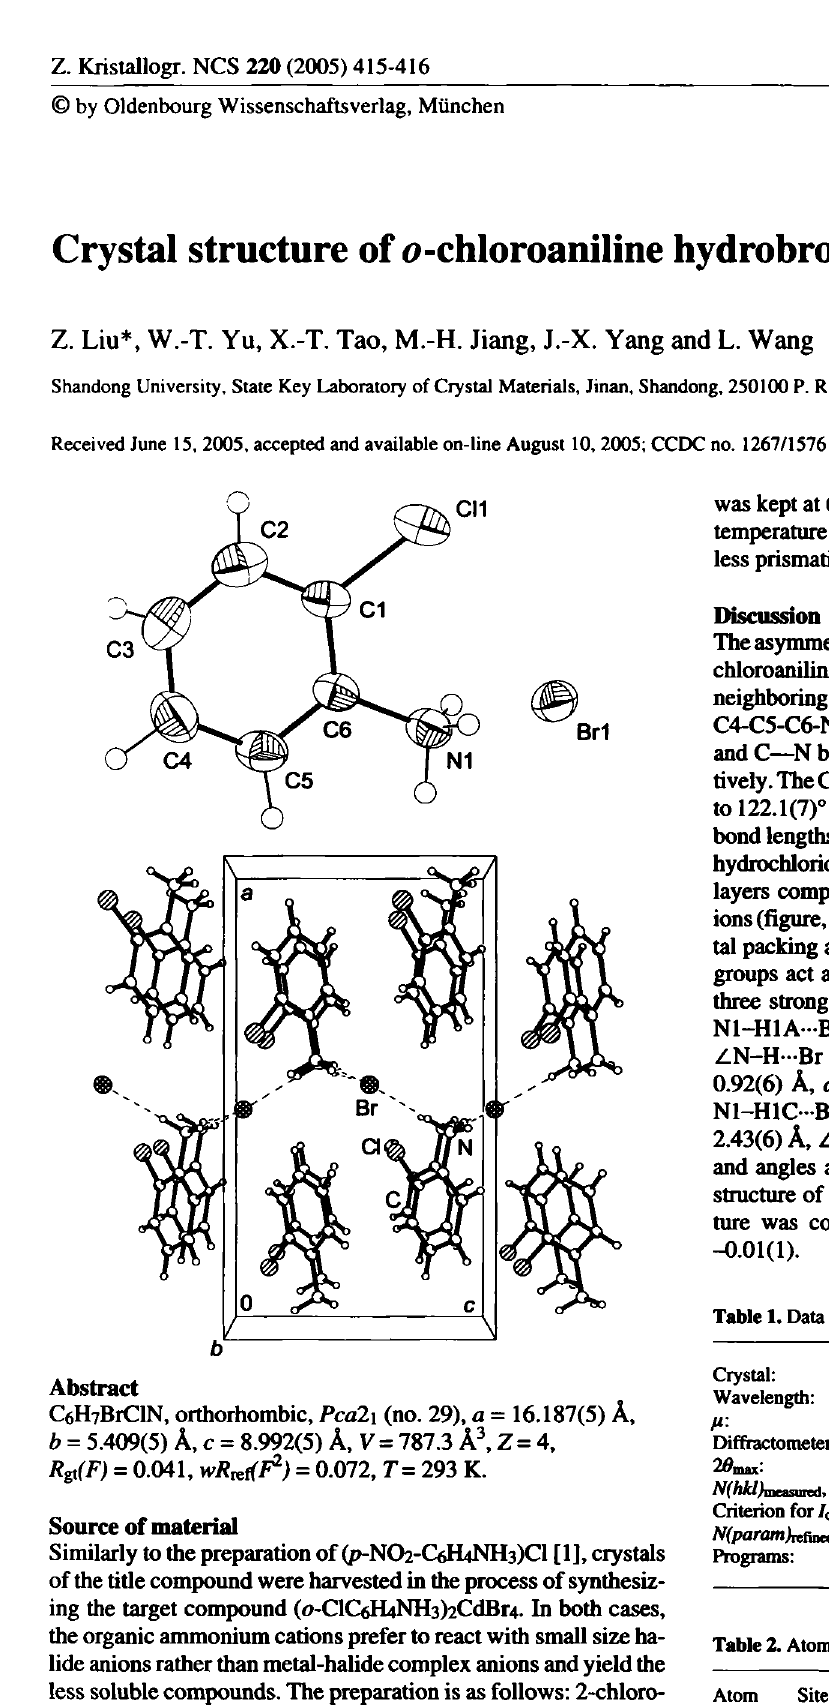
Table 2. Atomic coordinates and displacement parameters (in Ä 2